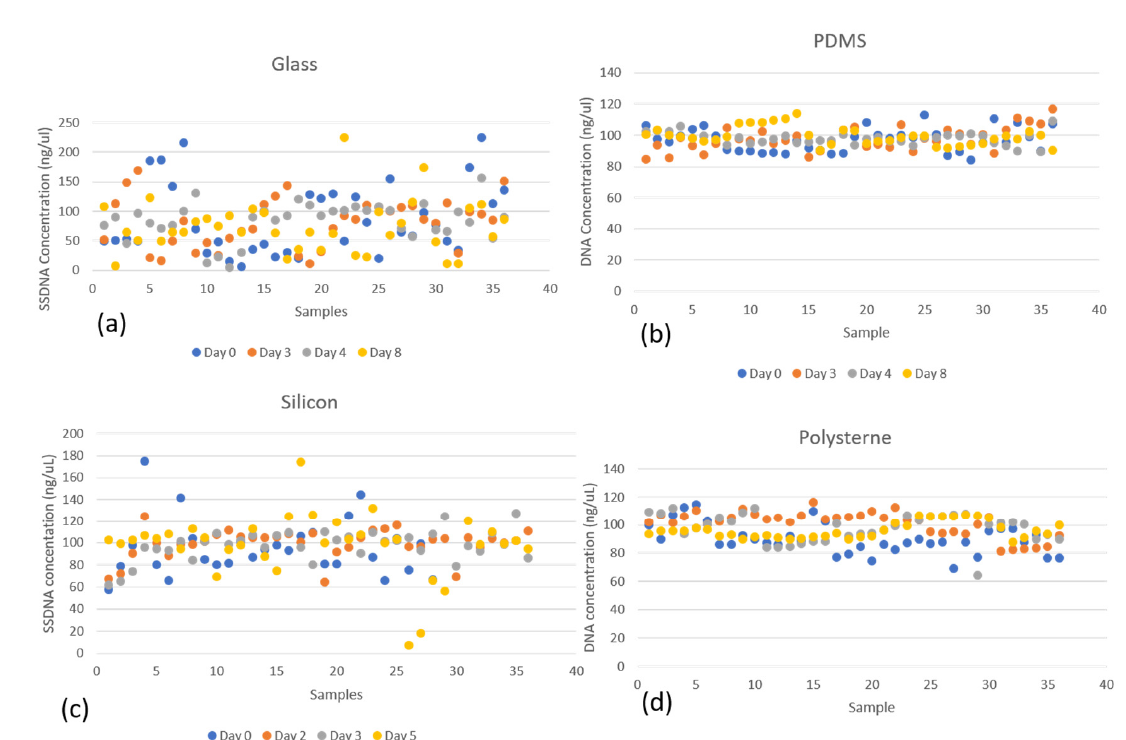
Figure 4. The effect of hydrophilicity and hydrophobicity of surfaces at different times: ( a ) Glass; ( b ) PDMS; ( c ) Silicon; ( d ) Polystyrene.